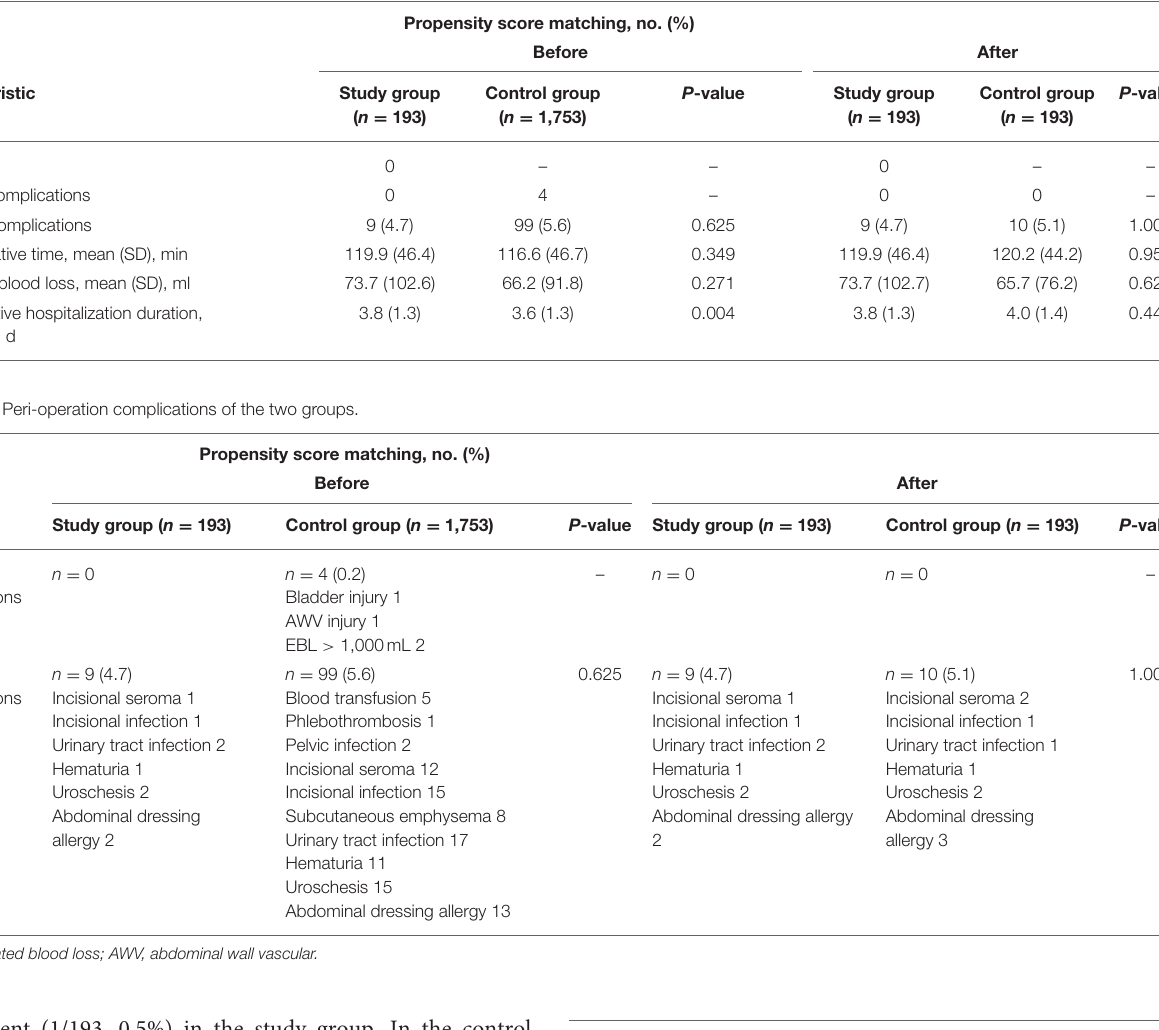
TABLE 2 | Perioperative outcomes of the two groups. Characteristic